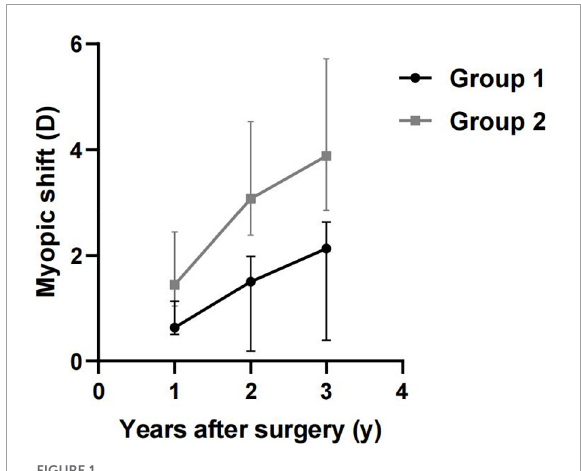
FIGURE1 Comparison of myopic shift (MS) at 1–3 years after surgery in Group 1 and Group 2.